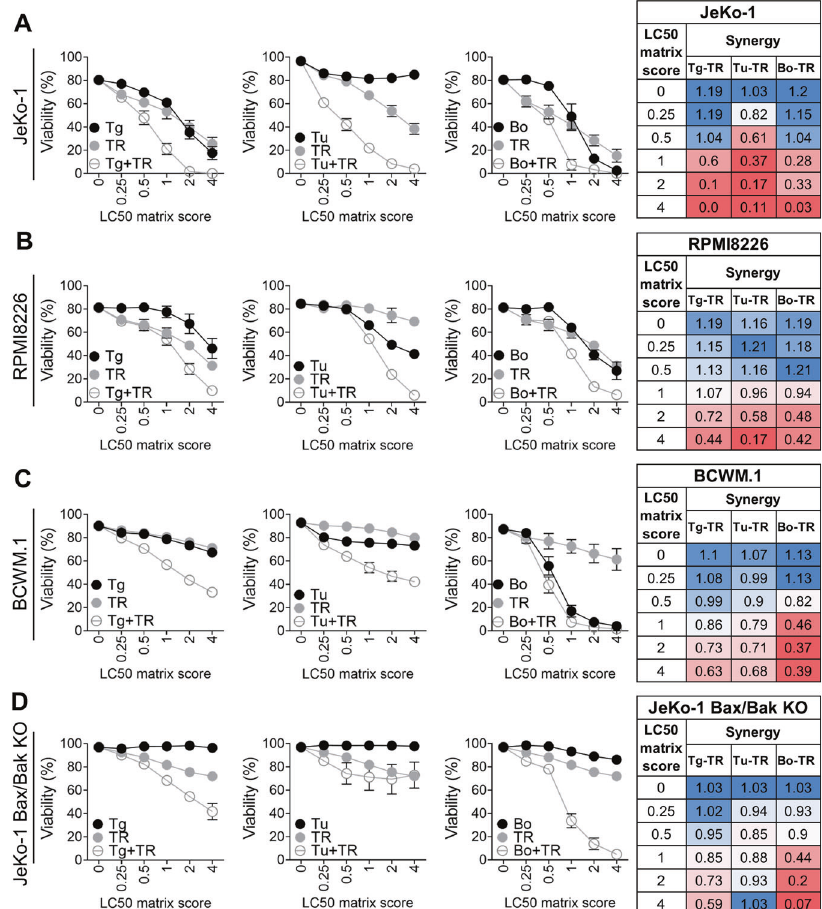
Fig. 6 Synergy between TRAIL and ER-stress inducers in B cell lines. A JeKo-1 cells were incubated with Thapsigargin (Tg), Tunicamycin (Tu), Bortezomib (Bo), or TRAIL (TR) or the combination of the ER stress drugs with TRAIL for 24 hours. Cells were then collected and viability was measured via FACS using DiOC6 and ToPro-3 staining. Results are shown as Mean ± SEM ( N = 3). Table shows synergy combination index scores calculated based on viability values of the curves. The scores in blue represents no synergy and in red strong synergy. B Same as A but with RPMI8226 cells. Results are shown as Mean ± SEM ( N = 3). C Same as A but with BCWM.1 cells. Results are shown as Mean ± SEM ( N = 3). D Same as A but with JeKo-1 Bax/Bak DKO (clonal population) cells. Results are shown as Mean ± SEM ( N = JeKo-1 cells a KO pool was used for DR4, and clonal populations were used for DR5, DR4/5, Bax/Bak DKO, Caspase-8 and Bid. In RPMI8226 cells KO pools were used for DR4 and DR4/5 DKO, and clonal populations for DR5, Bax/Bak DKO and Caspase-8. In BCWM.1 cells a KO pool was used for DR4/5 DKO, and clonal populations for DR4, DR5, DR4/5 and Bid clones. In A549 cells a KO pool was used for DR4, and clonal populations were used for DR5 KO and DR4/5 DKO.